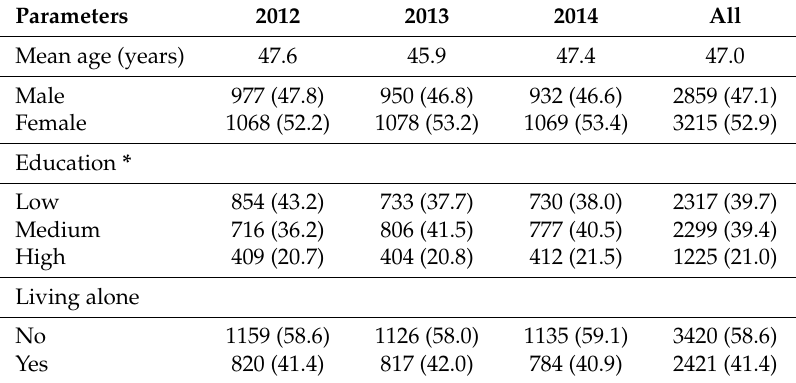
Table 1. Study population, education, and living